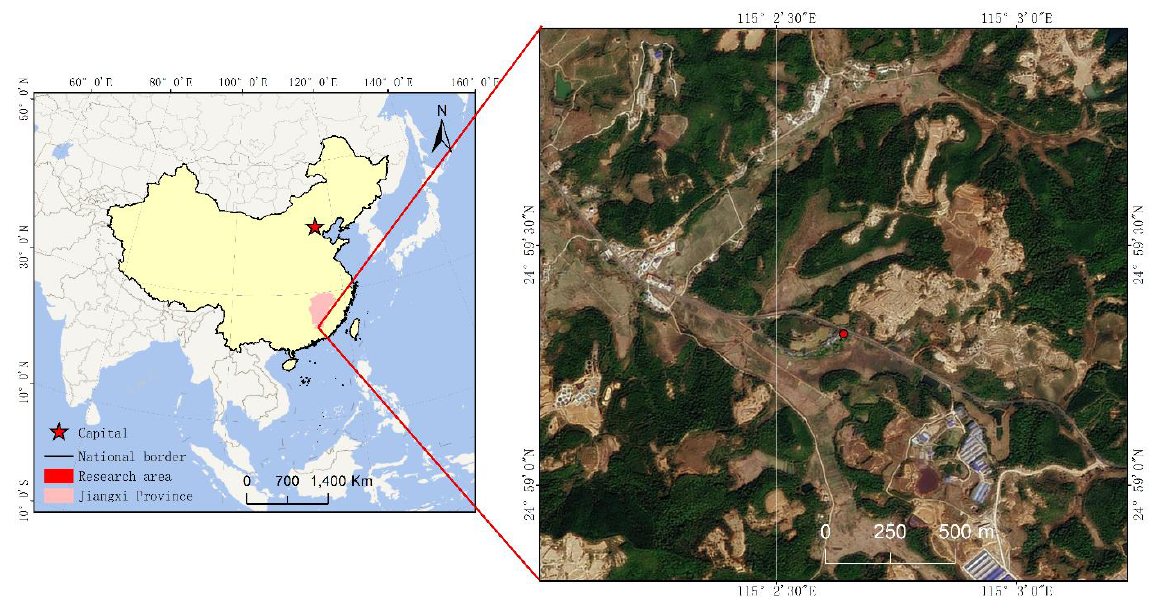
Figure 1. Location of the study